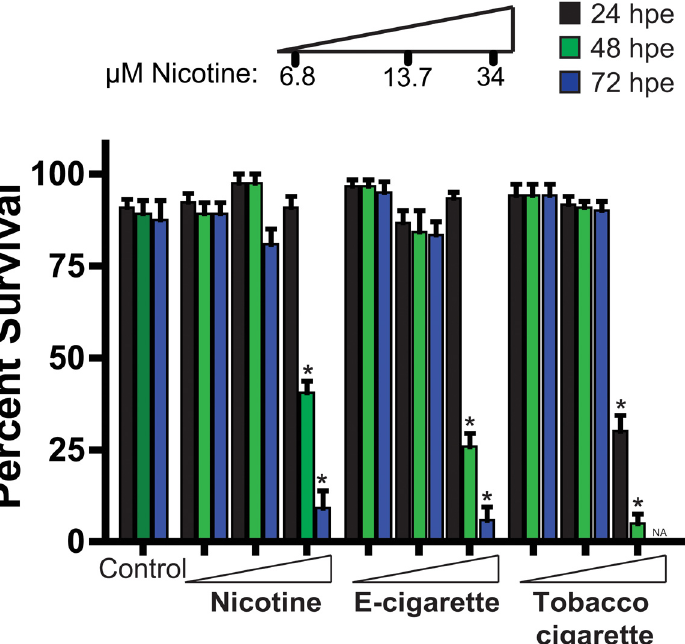
Fig 1. Zebrafish embryo-larval survival analysis following escalating doses of nicotine, e-cigarette and tobacco extracts. Assessment of zebrafish survival over 72 h with increasing concentrations of pure nicotine, e-cigarettes and tobacco cigarettes extracts or vehicle control (0.1% DMSO). n (cid:3) 3 (independent experiments with each n containing between 24 – 48 animals per treatment). * P < 0.05, hpe = hours post